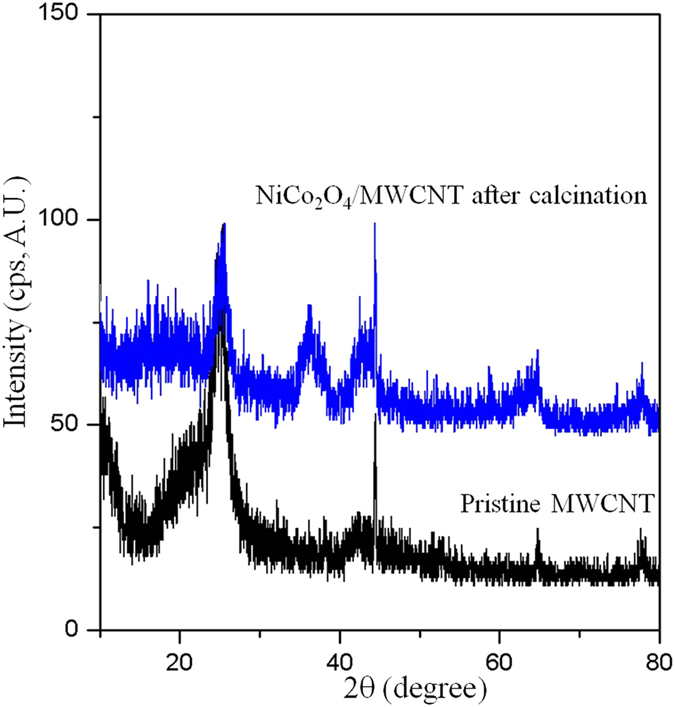
X-ray diffraction patterns of pristine MWCNT and NiCo2O4/MWCNT after calcination at 300 °C.